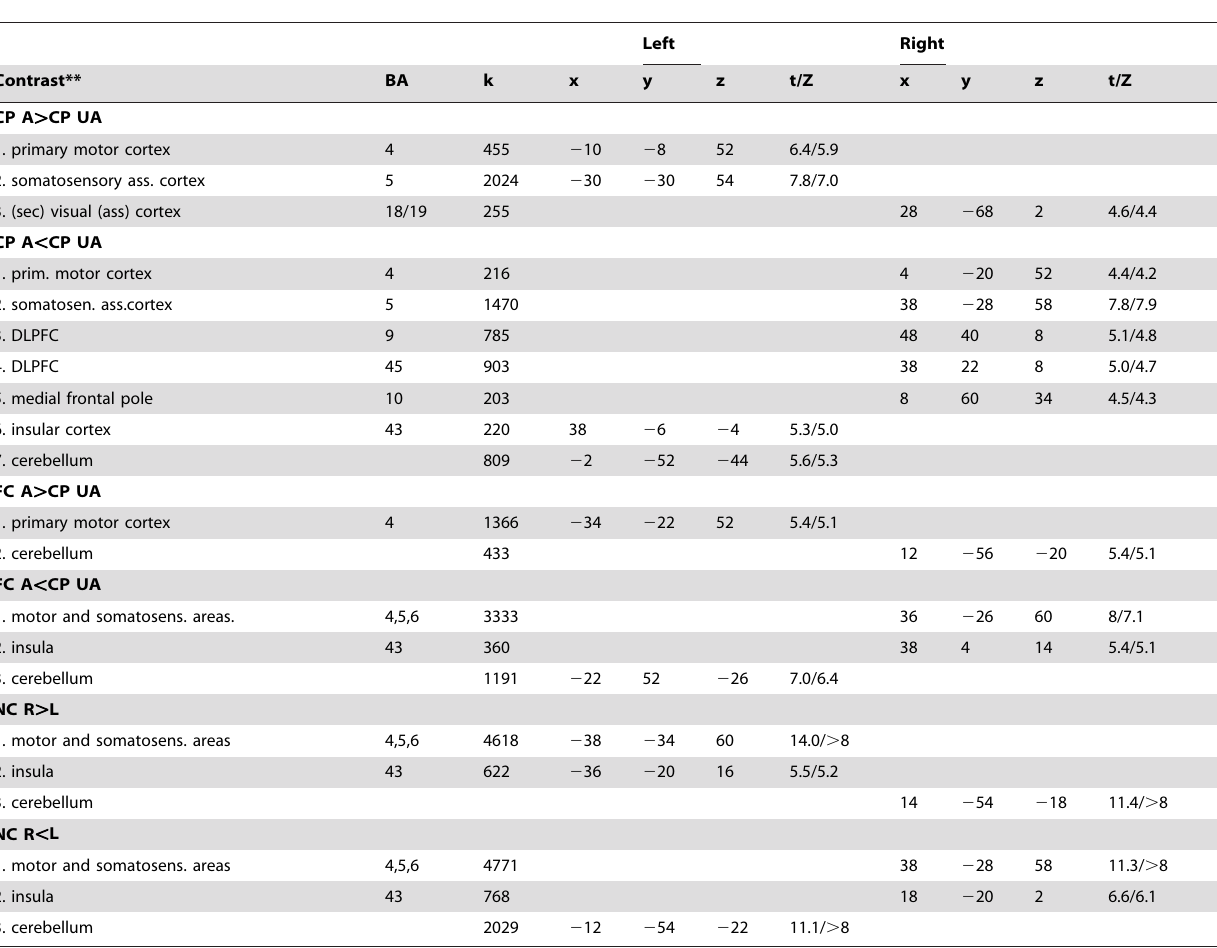
Table 3. Cerebral activation in within-group comparison Affected versus Unaffected* in patients and feigners) side during movement